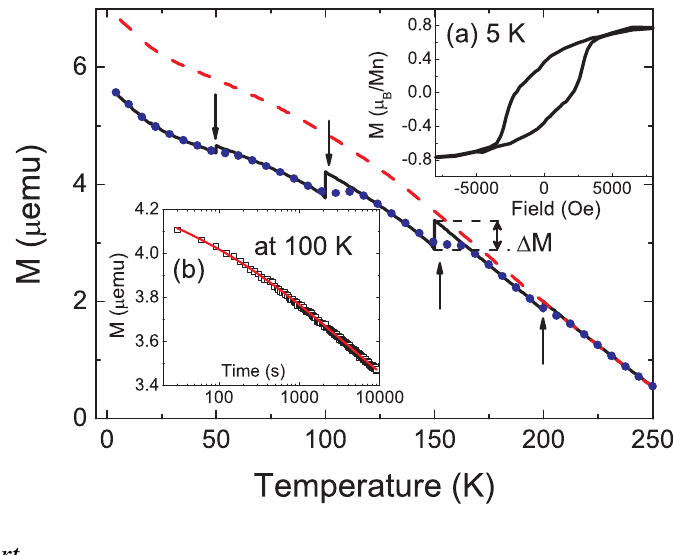
Figure 10 . Temperature dependent memory effect in the dc magnetization of the GeMn precipitates inside the Ge matrix. The dashed line (red) is measured during cooling in 50 Oe at a cooling rate of 1 K per minute, while the solid line (black) is measured in 50 Oe with the same cooling rate but with a stop of 2 hours at 200 K, 150 K, 100 K, 50 K and 20 K. The field is cut off during stop. The dotted line (blue) is measured with continuous heating at the same rate after the previous cooling protocol. Inset (a): Hysteresis loop measured at 5 K. Inset (b): Time dependent remanent magnetization measurement after cooling from 300 K to 100 K with a field of 50 Oe. Scattered symbols are experimental data and the solid line (red) is a fitting using the stretched-exponential function. (Reprinted with permission from Ref. [42]. Copyright 2009, American Institute of